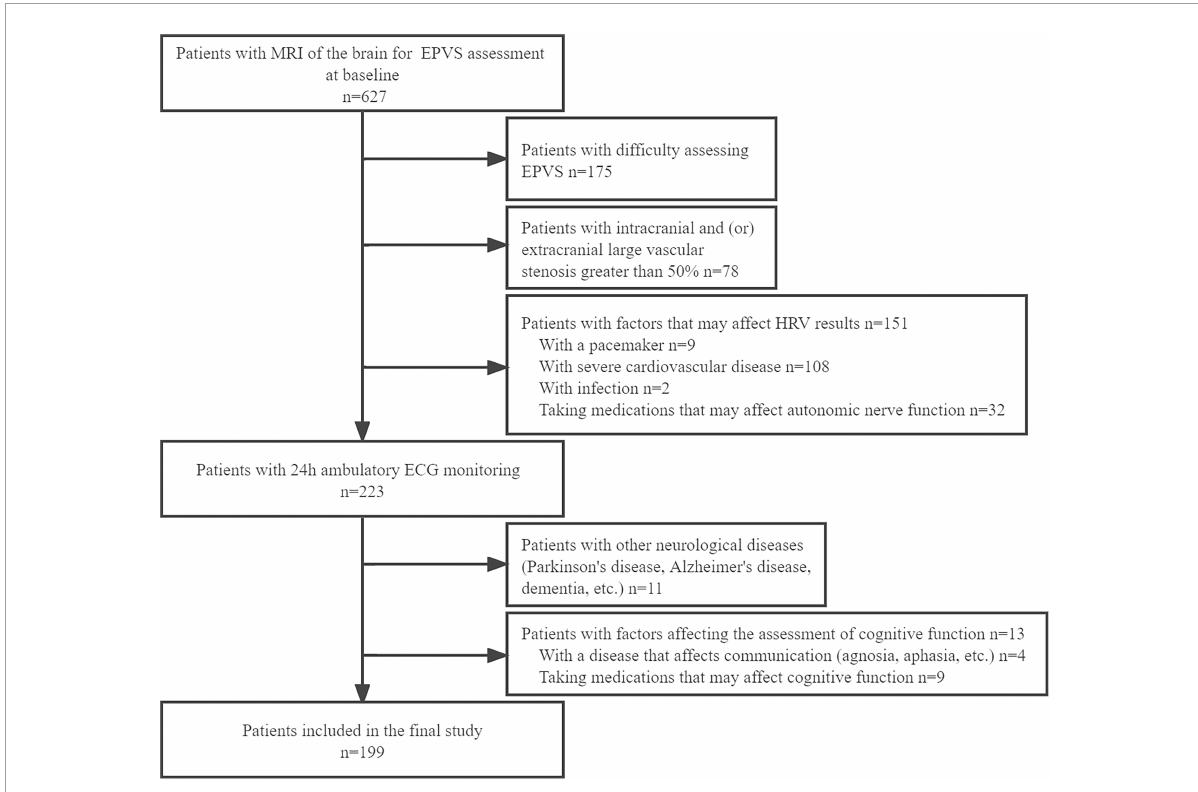
FIGURE1 Flowchart of enrollment of study patients. MRI, magnetic resonance imaging; EPVS, enlarged perivascular spaces; HRV, heart rate variability; ECG, electrocardiogram.